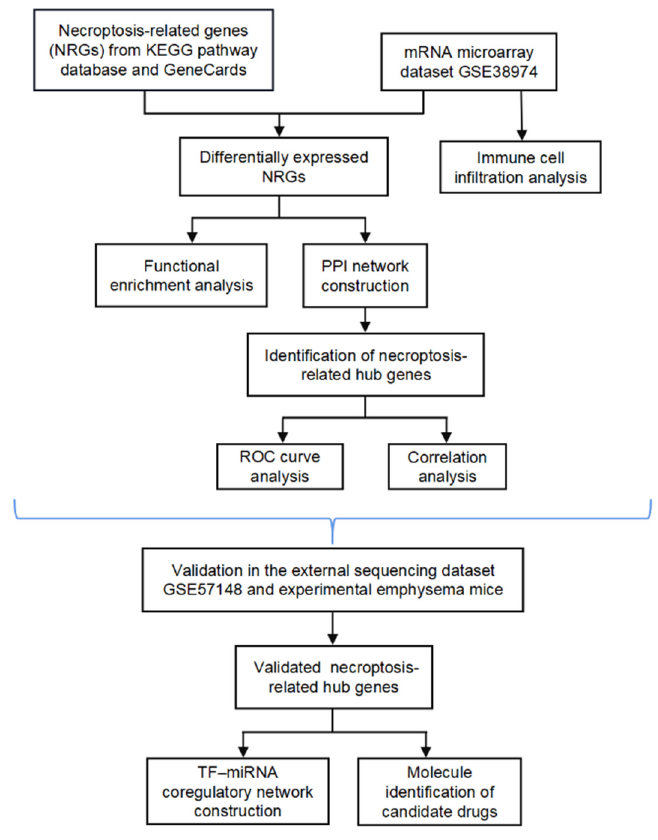
Figure 1. Flow Figure 1. Flow chart.